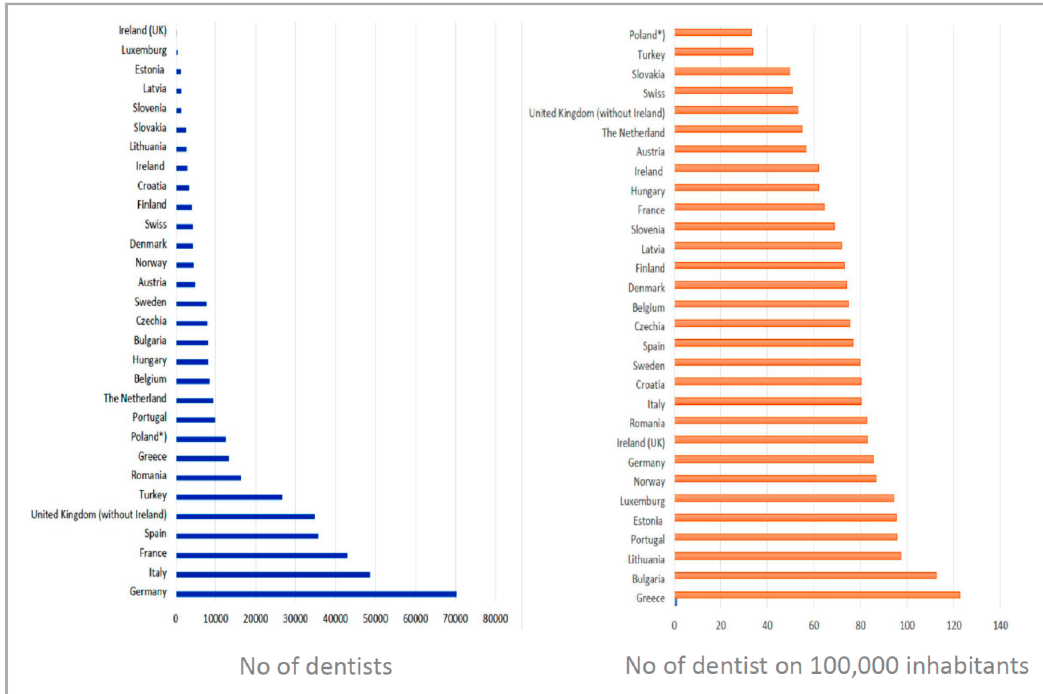
Figure 31. The detailed distribution of dentists in individual European countries (* Supreme Medical Chamber in Poland on behalf of the Government of Poland on 10 February 2020, sent a letter to Eurostat, correcting incorrect information because, in Poland, 42,425 people currently have the right to practice the profession of dentists in Poland, most of whom are dentists registered as practicing this profession. No. of dentist in 100,000 inhabitants should be 112.1).